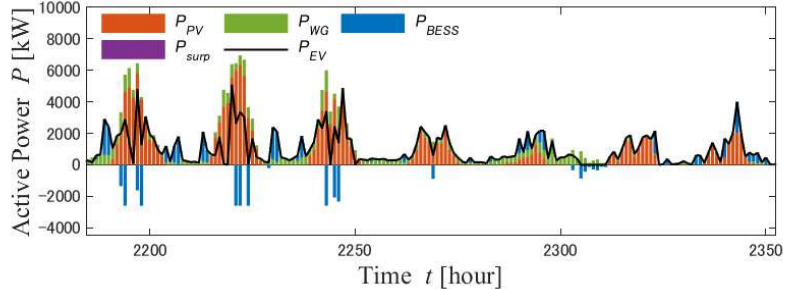
Figure 14. Generated power and load from July 1 to 7 (Case 1).